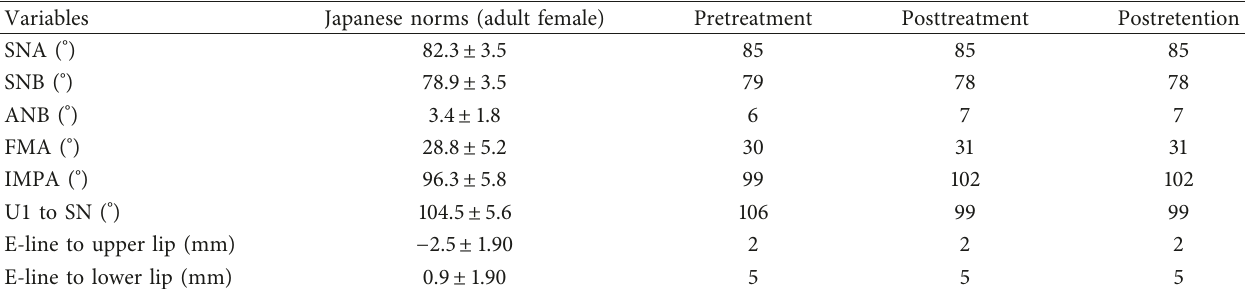
Table 1: Summary of the cephalometric